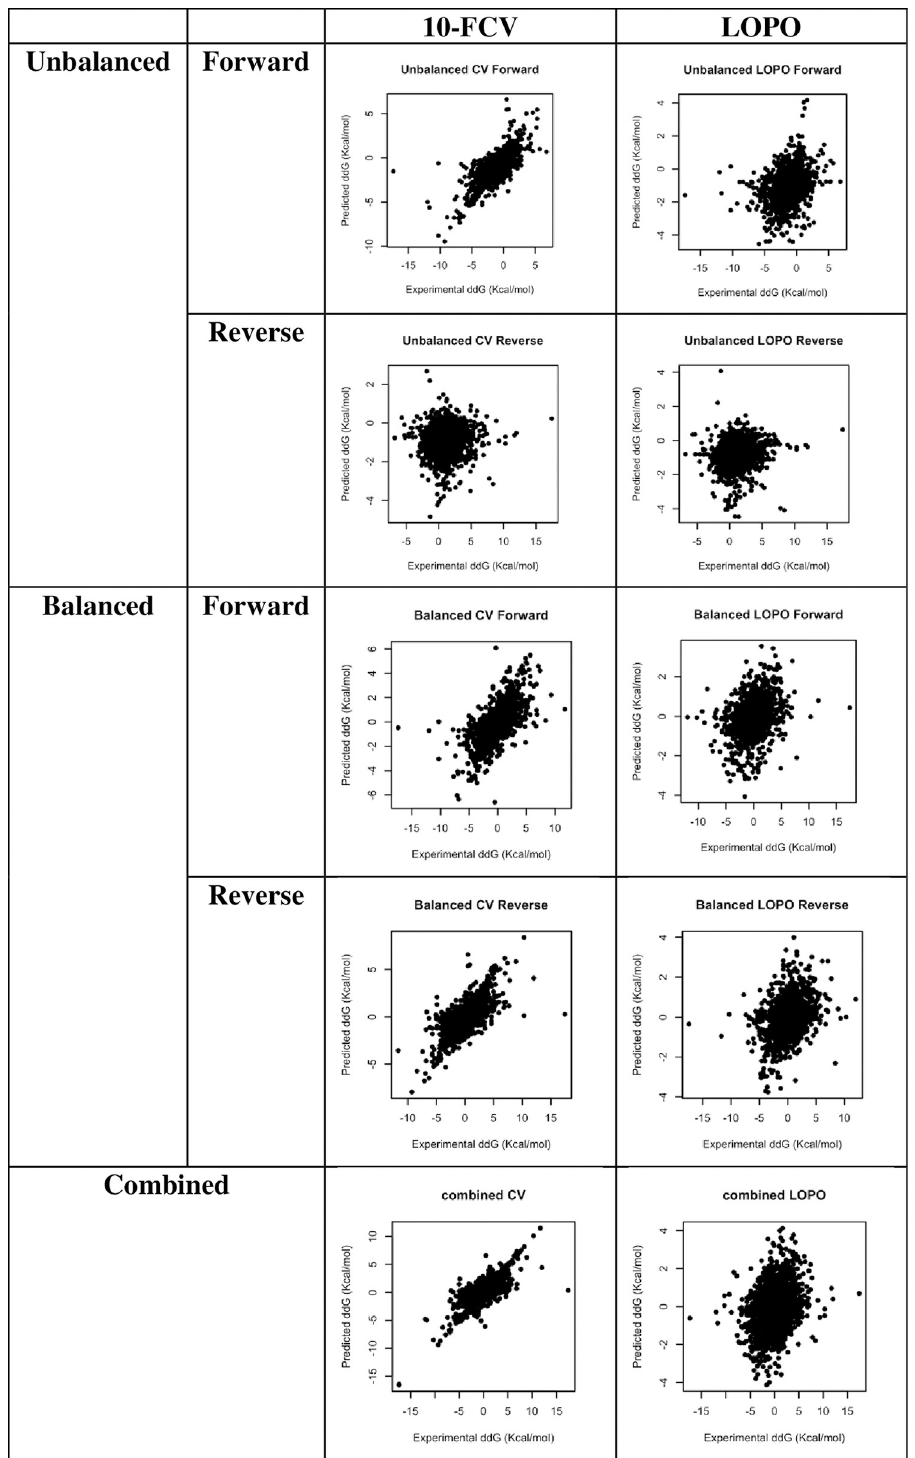
Fig 1. Scatter plots of experimental ΔΔ G versus predictions of unbalanced, balanced, and combined approaches.